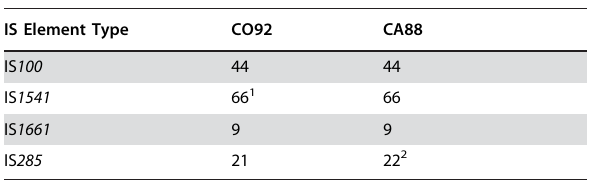
Table 4. IS element counts in CO92 and CA88. .. ... .... ... ... .... ... ... .... ... ... .... ... ... .... ... ... .... ... ... .... .